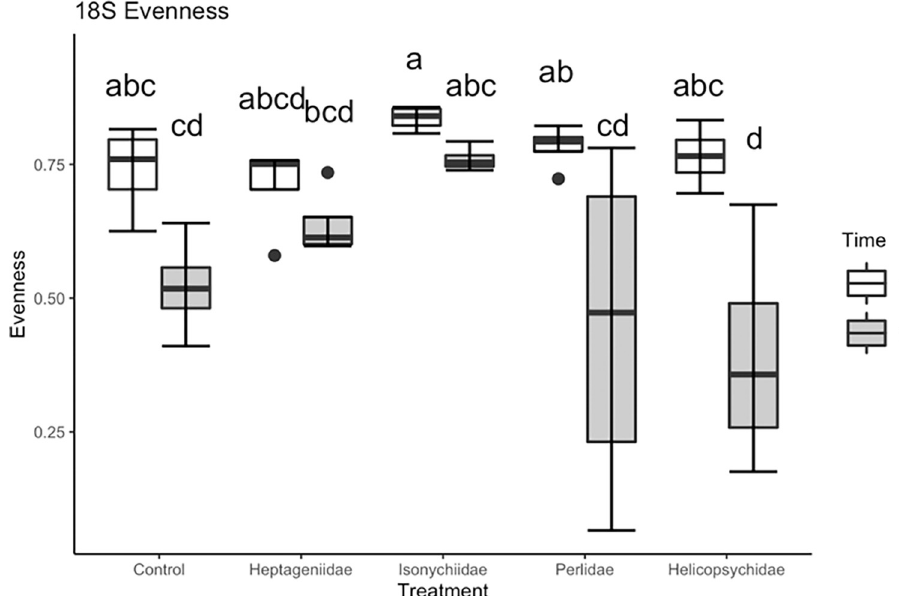
Fig 6. Lower eukaryotic (18S) lake sturgeon egg surface community evenness (means ± SE) for estimated across aquatic insect treatments during time 1 and time 2 (1 da and 4 da post fertilization, respectively).